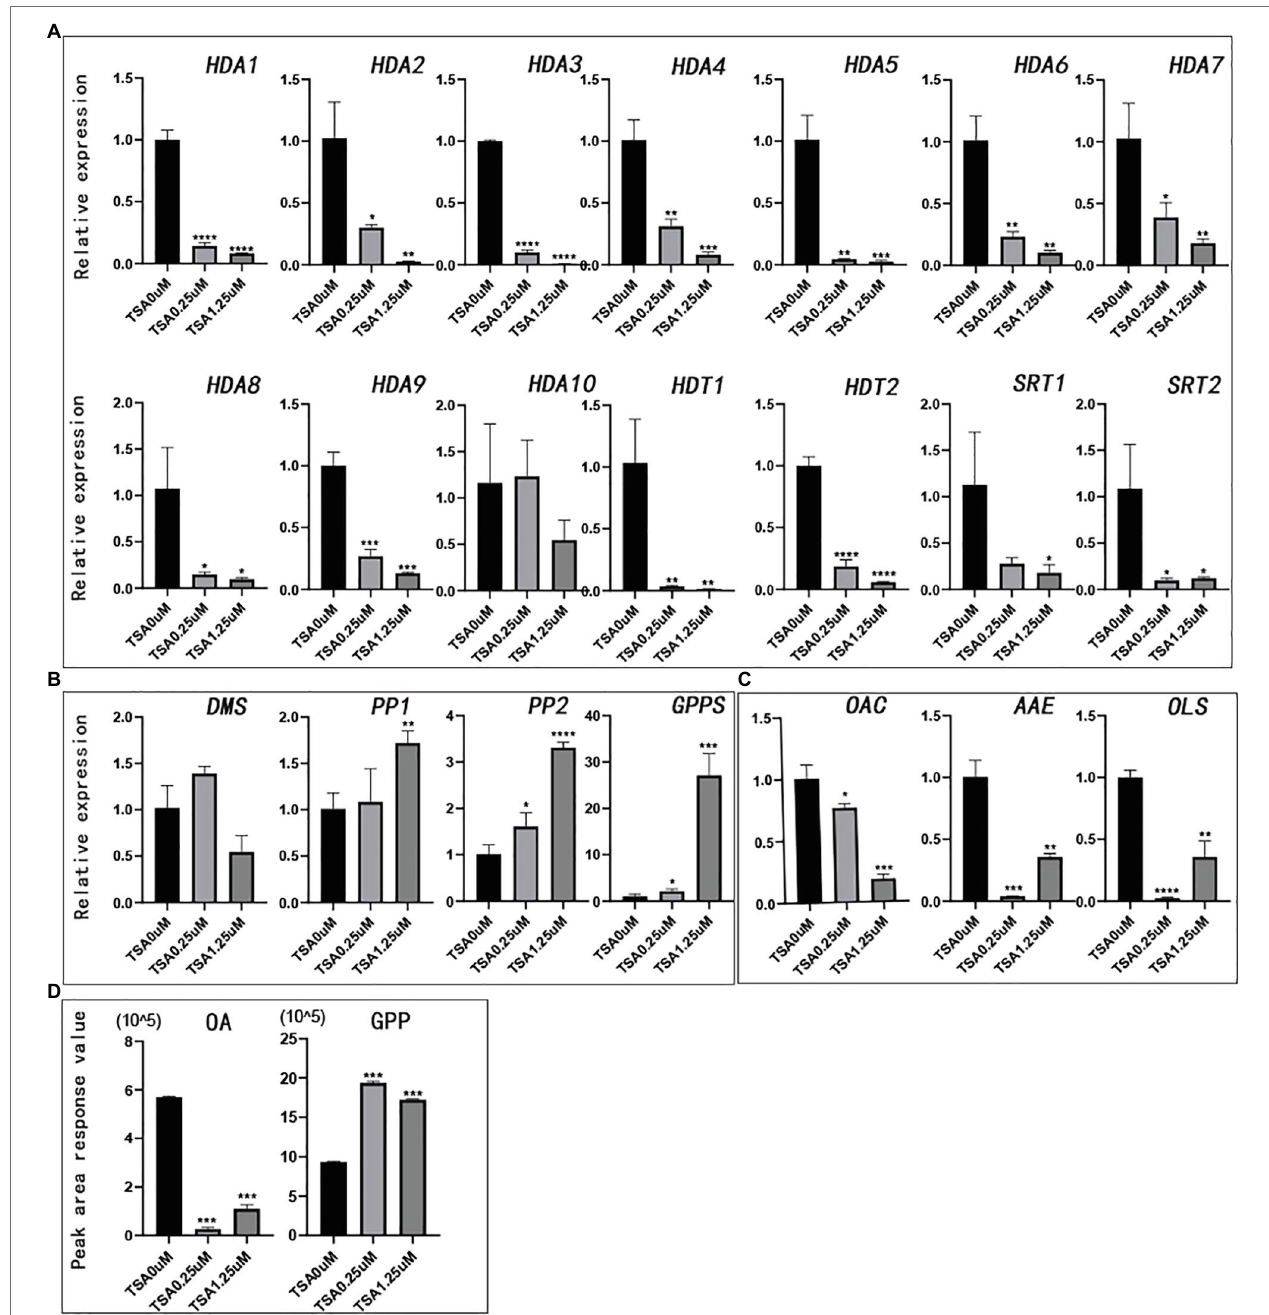
FIGURE 7 | The relative expression of genes and the peak area of synthetic precursors OA and GPP after TSA treatment. The control was performed with 0 μ m TSA (DMSO matrix) treatment. n = 3. (A) The relative expression of partial histone deacetylase genes; (B) The relative expression of key genes in the MEP pathway; (C) The relative expression of key genes in the fatty acid pathway; and (D) Peak area of synthetic precursors OA and GPP. *value of p < .05, **value of p < 0.01, ***value of p < 0.001, and ****value of p <